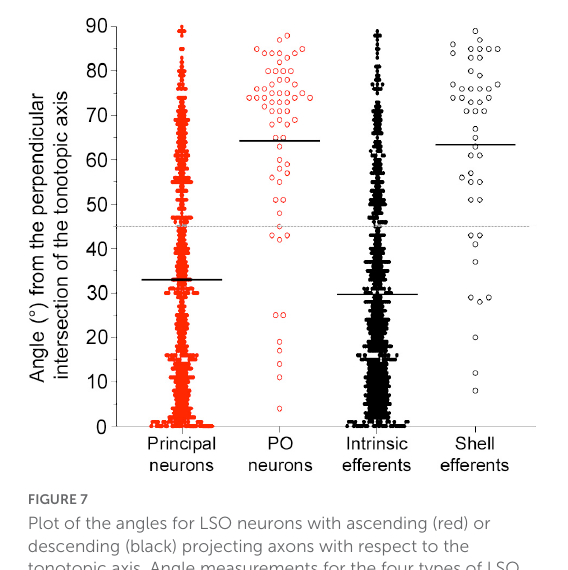
FIGURE7 Plot of the angles for LSO neurons with ascending (red) or descending (black) projecting axons with respect to the tonotopic axis. Angle measurements for the four types of LSO neurons are shown and combined from three regions of the LSO (rostral, middle, and caudal sections). The average angle (black line) was presented for all subtypes. Gray dashed line: 45-degree threshold. Principal and intrinsic neurons illustrate similar angle deviations, with mean alignment below the 45-degree threshold across all planes. Periolivary (PO) neurons and shell efferent neurons both had values above the 45-degree threshold for all planes. Smaller values indicate alignment with the frequency organization. PO,